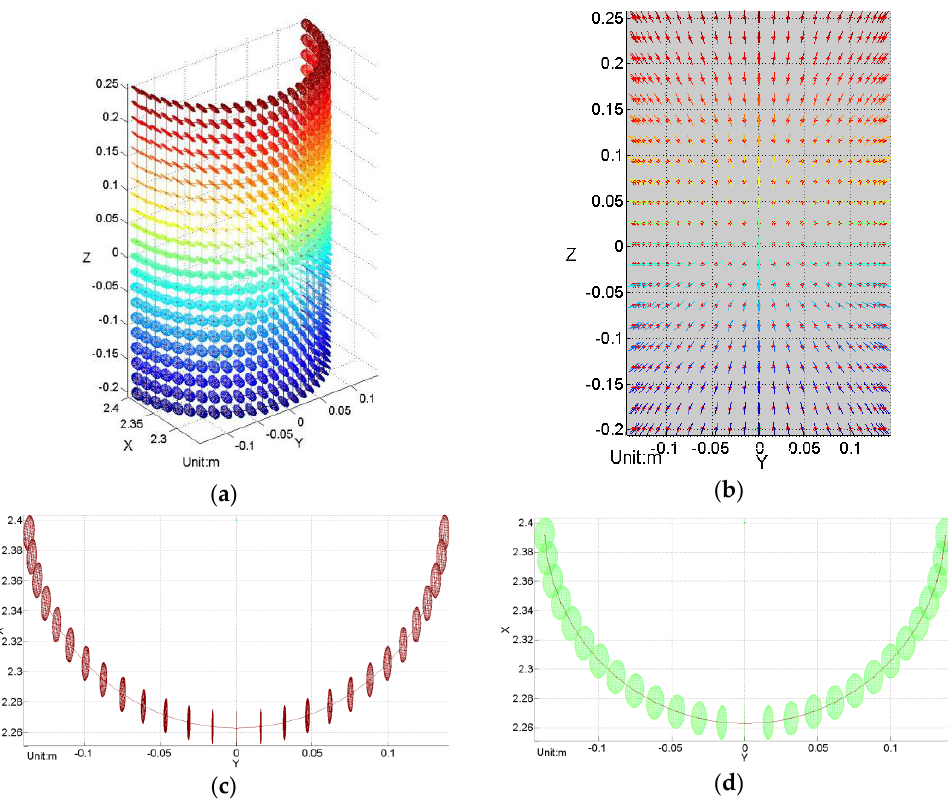
Figure 4. ( a ) Uncertainty ellipsoid map of a standing cylinder surface. ( b ) Front view of y - z plane direction, ( c ) Top view of the top section of the cylinder. ( d ) Top view of the middle section of the cylinder. The optical center of the laser radar is located at the origin of the coordinate system. ( a ) and ( b ) illustrate the distribution of uncertainty ellipsoids on a standing cylinder surface, showing that the range measurement uncertainty is the main error contribution. ( c ) and ( d ) imply that the uncertainty in horizontal direction of each point increases towards the cylinder edges. Moreover, the sizes of ellipsoids increase with the range distance and the orientation angle relative to the optical axis, which is along the intersection line of the central scanning plane and the rotation plane.